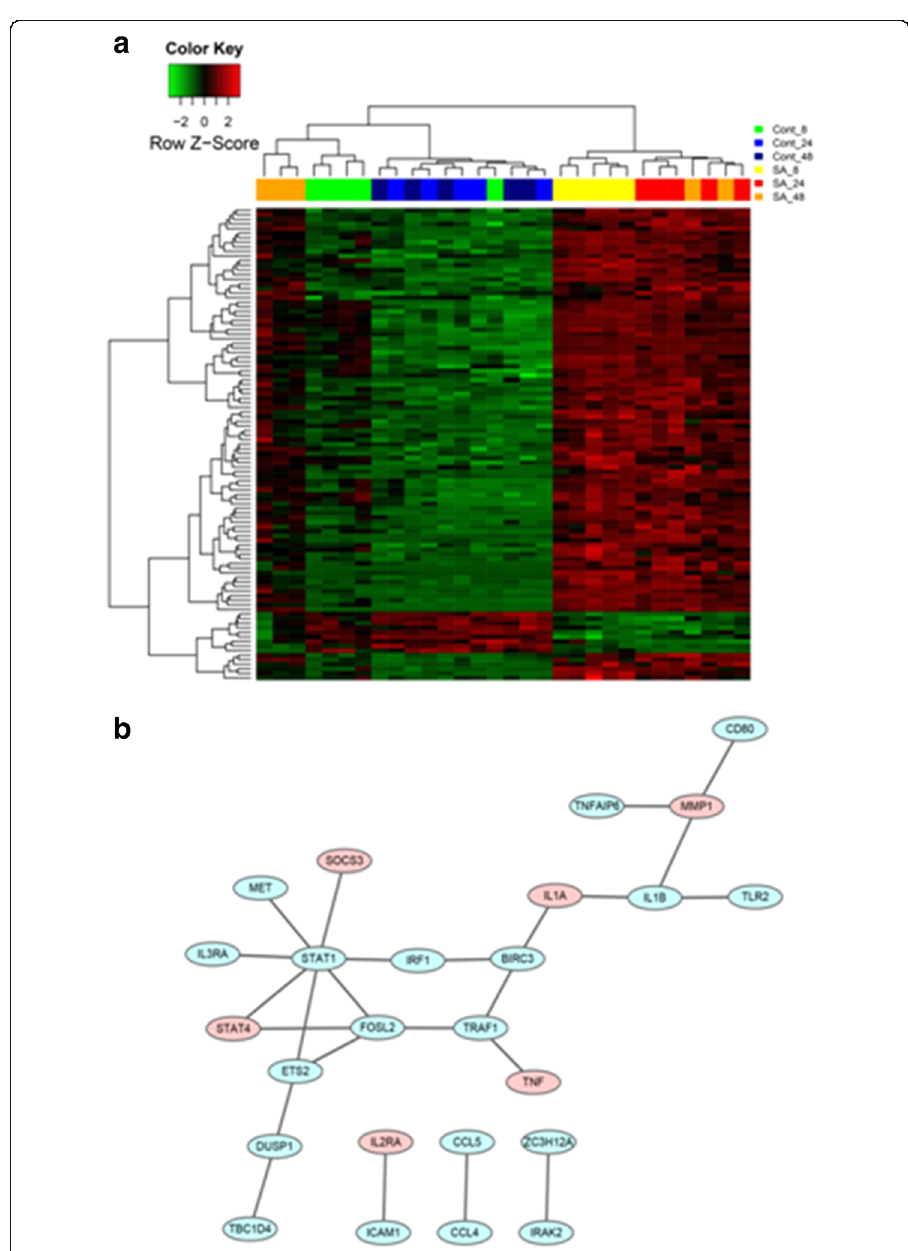
Fig. 2 Heat map of common DEGs of all 3 comparisons ( a ) and corresponding biological network ( b ). a Heat map of hierarchical clustering in all datasets for common DEGs. “ Red ” : high expression, “ green ” : low expression. b Biological network constructed according to the direct connection among DEGs. “ Red ” : up-regulation, and “ green ” :